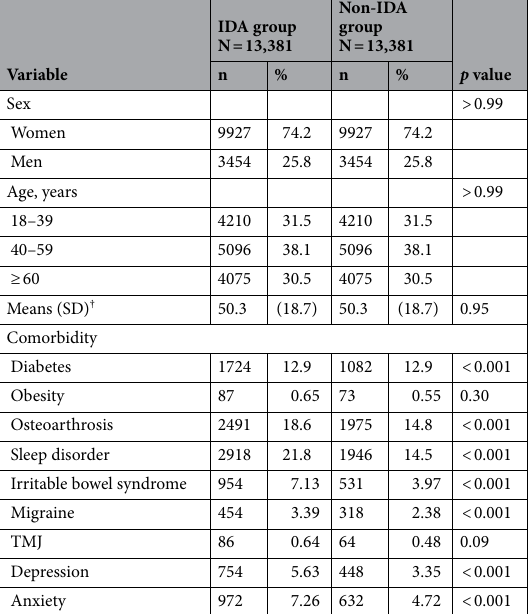
Table 3 summarizes the risk of FM stratified by sex, age, and comorbidity. Women with IDA had a 1.22-fold higher risk of developing FM compared with individuals without IDA (HR, 1.22; 95% CI, 1.15–1.29). However,